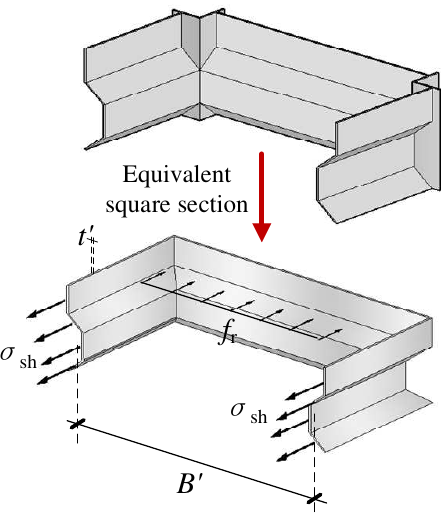
Figure 17. Equivalent conversion and force equilibrium.